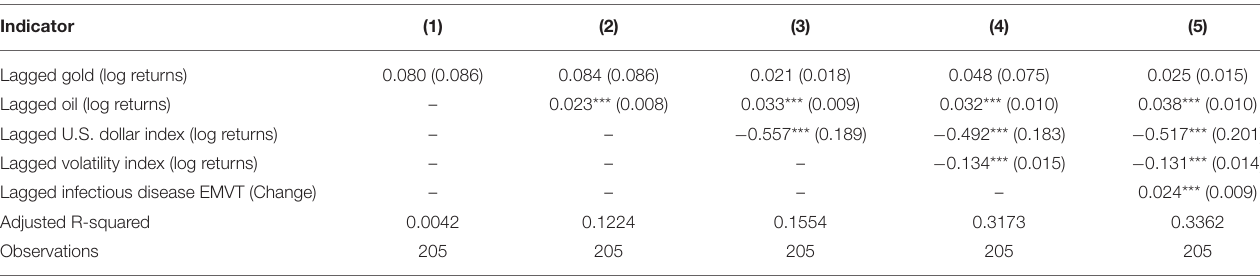
TABLE 6 | Results of the LARS estimations: April 15, 2020–February 19, 2021 (lagged model).